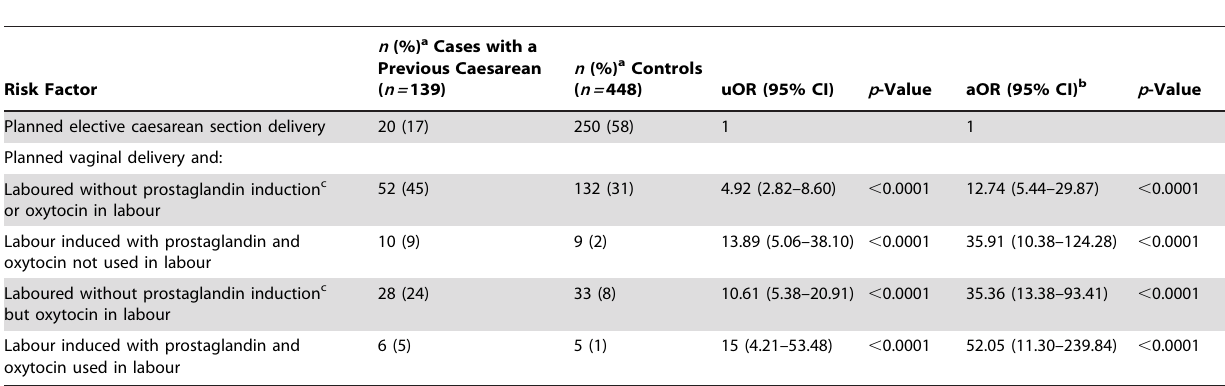
Table 4. Risk factors for uterine rupture in women with prior delivery by caesarean